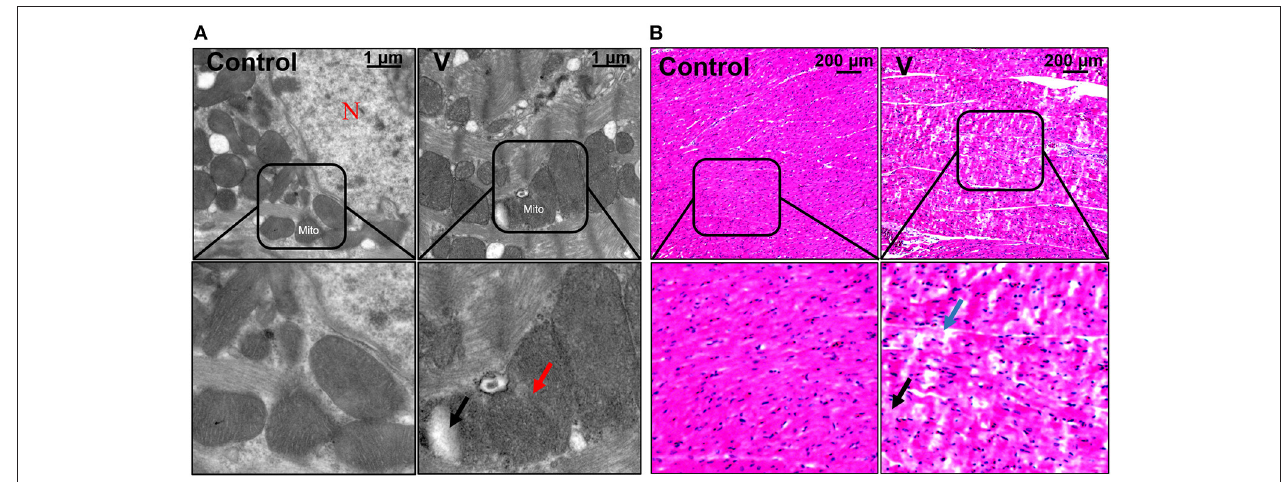
FIGURE 1 | The changes of histomorphology in the heart of ducks on 44 days. (A) TEM observation. The scale bar is 1 µ m. The red arrow refers to mitochondrial swelling. The black arrow refers to mitochondrial vacuolization. N, nucleus; Mito, mitochondria. (B) Pathological observation of the hearts in ducks. Scale bar, 200 µ m. The black row indicates granular degeneration of cardiomyocytes. The blue row indicates the vacuolar degeneration of cardiomyocytes.